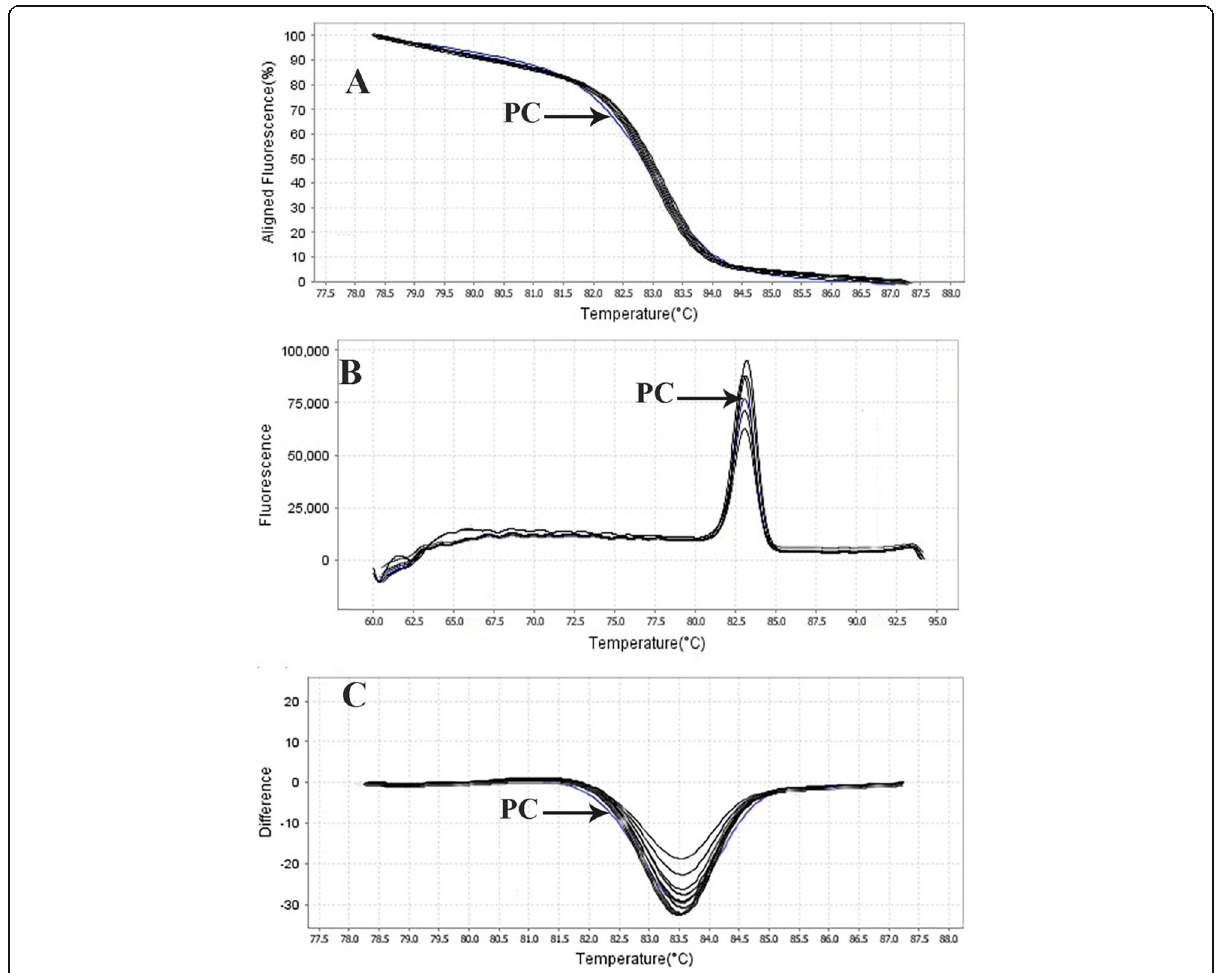
Fig. 8 HRMA graphs corresponding to one high-resolution melting analysis of a subset of clinical specimens of E. faecalis . DNA samples in this study were prepared and amplified successfully using the EvaGreen dye-based method in the ABI instrument. Primer-specific melting peaks (Tm) were obtained via HRM analysis, allowing the differentiation of all investigated β -lactamase enzymes. Due to the highly saturating EvaGreen dye and the HRMA analysis, the accuracy of the resolution was ± 0. 1 – 0.5